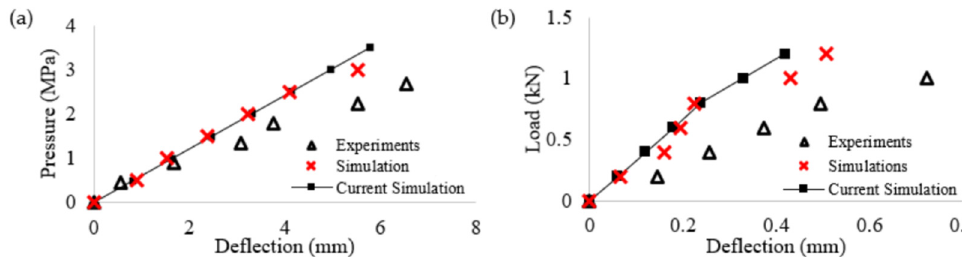
Figure 6. Validation of ANSYS model for simulation of quasi-static analysis on ( a ) metal grillage [20] and ( b ) sandwich structure [21].